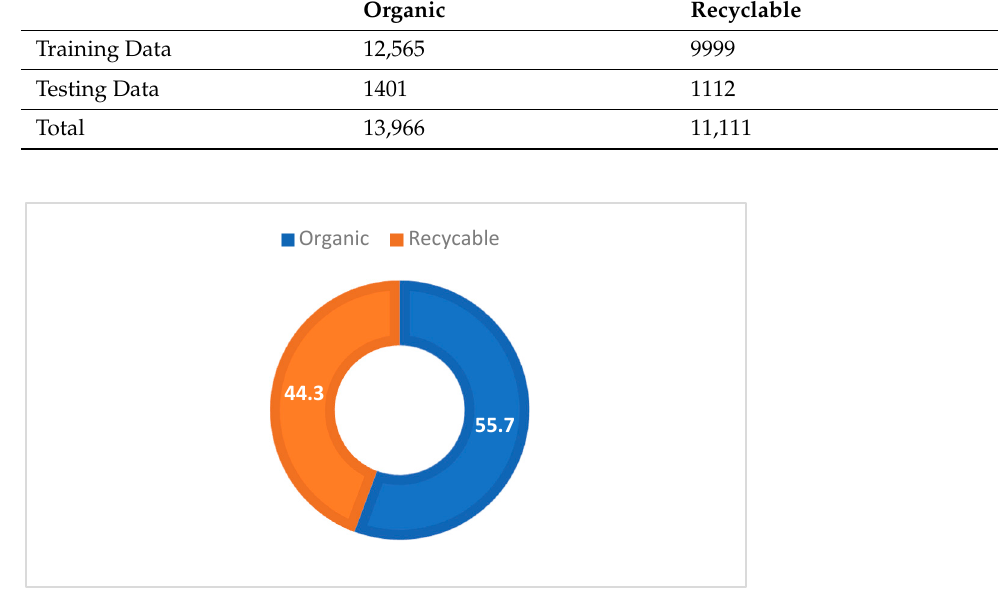
Table 2. The amount of waste images included in the dataset.